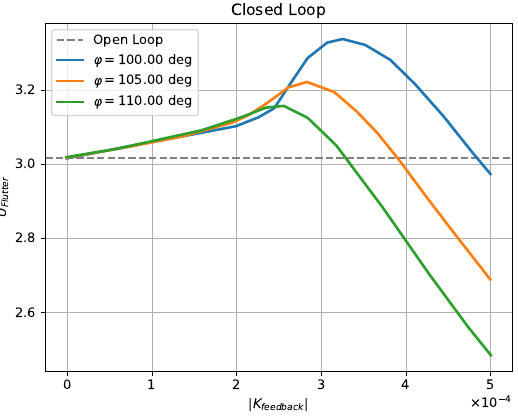
Figure 9. Flutter speed as a function of feedback gain modulus and feedback phase.